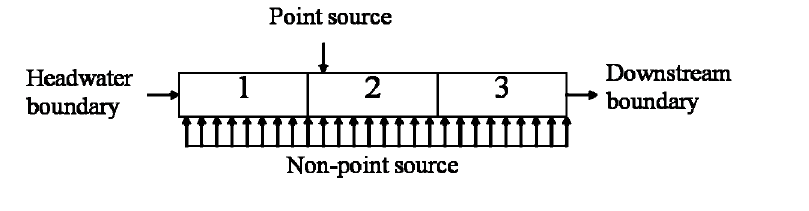
Figure 3. Schematic representation of the three reaches of the Hongqi River, and their sources of pollution.